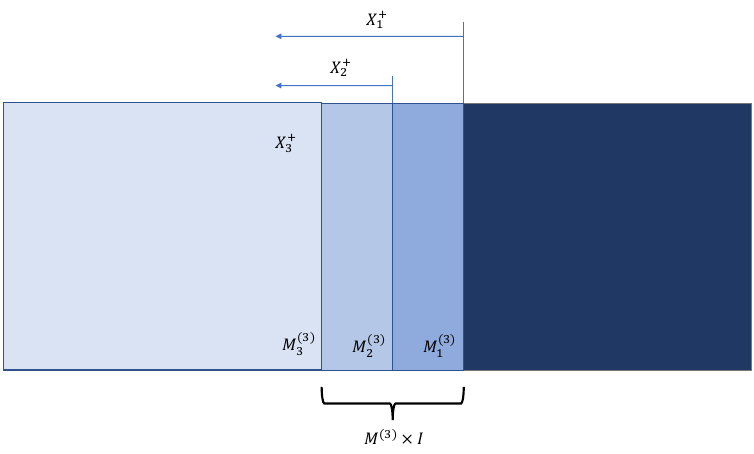
Figure 3 . Fusion rule of three duality defects D ( M (3) ) , and those hypersurfaces are infinitesimally displaced as D ( M (3) ) , D ( M (3) ) , and D ( M (3) ) 1 2 3